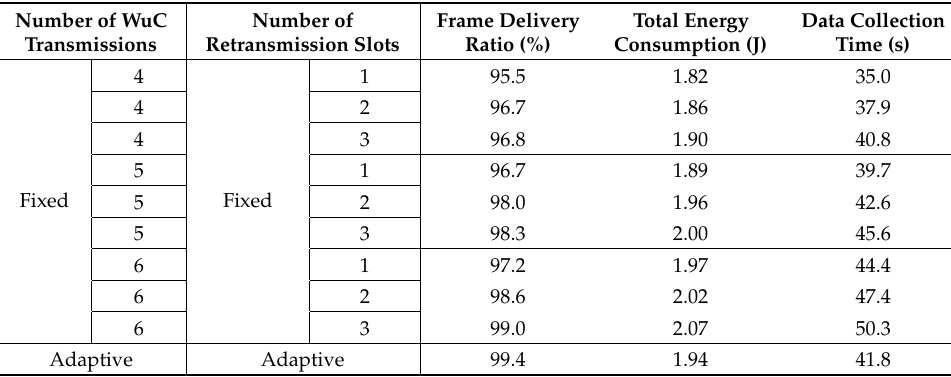
Table 4. Evaluation of dealing with frame